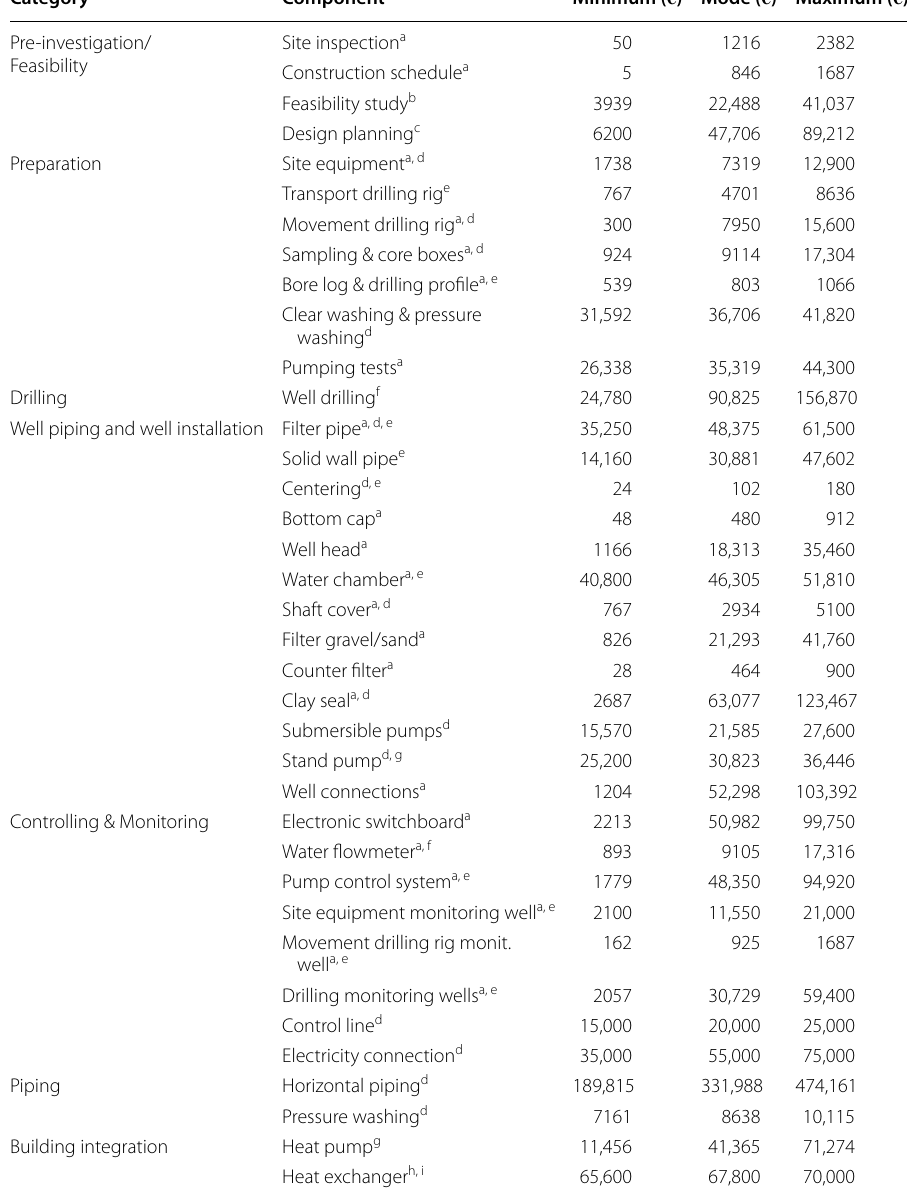
Table 4 Minimum, mode and maximum values for the Monte Carlo Simulation of the C